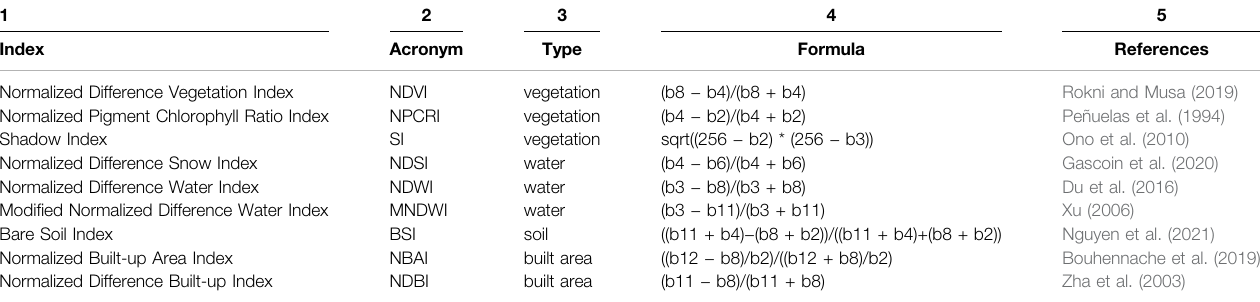
TABLE 1| TheseRaster Indicesderive fromcalculationsbased onSentinel-2 bandvalues. Usingtheformulas incolumn 4,weestimatedtheindicesinColumn 1toserve as